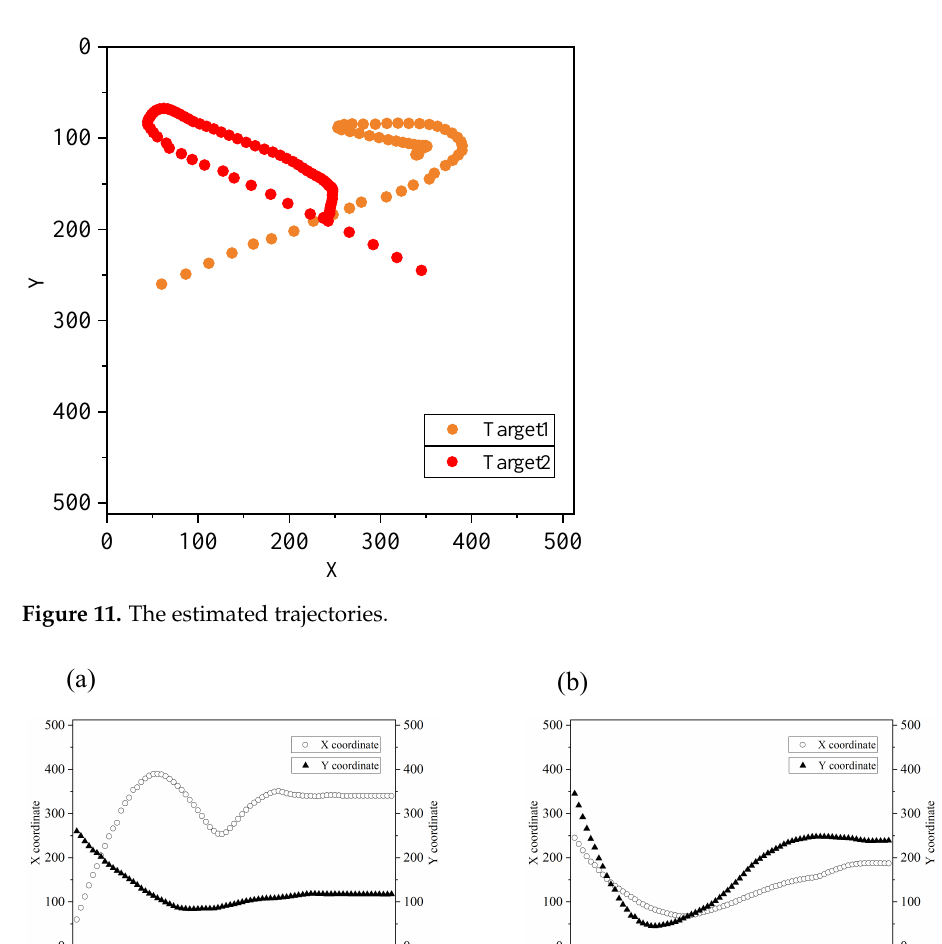
Figure 10. Estimated results in five different frames from the 260th frame to the 340th frame. The first row shows the scene images, and the second row shows the results of multi-target tracking. The real-time estimated position of Target 1 (representing the yellow ball on the left in the 240th frame) is marked with a red dot, and Target 2 (representing the red ball on the right in the 240th frame) is marked with a red triangle.